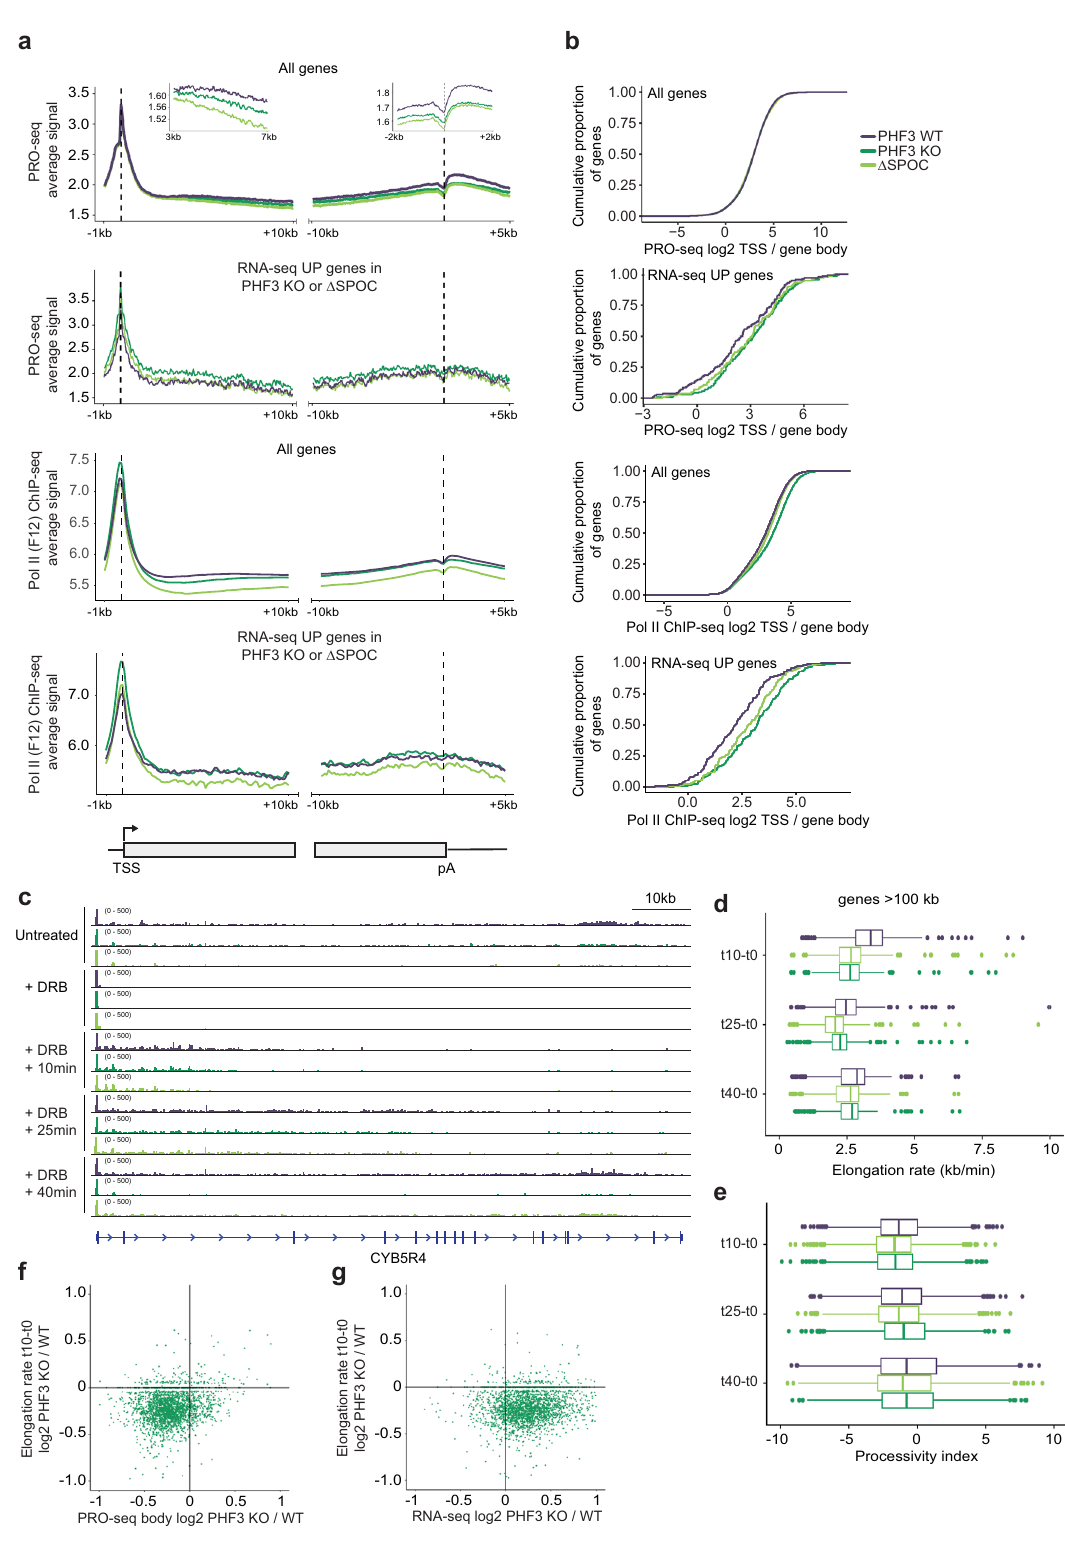
(Fig. 8c). Importantly, PHF3 Δ SPOC failed to rescue the PHF3 KO phenotype (Fig. 8c). PHF3 expression levels were found to be reduced in glioblastoma, the most common undifferentiated brain tumor 61 . To examine a